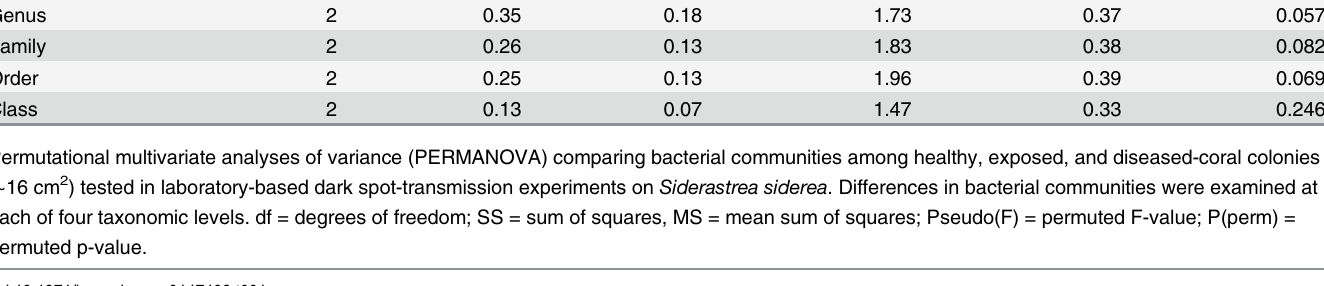
Table 1. PERMANOVA results of bacterial-community analyses on diseased and healthy corals.